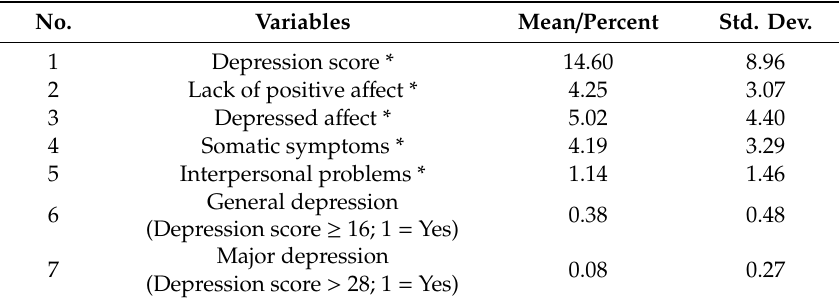
Table 2. Depressive symptoms across entire sample, n =